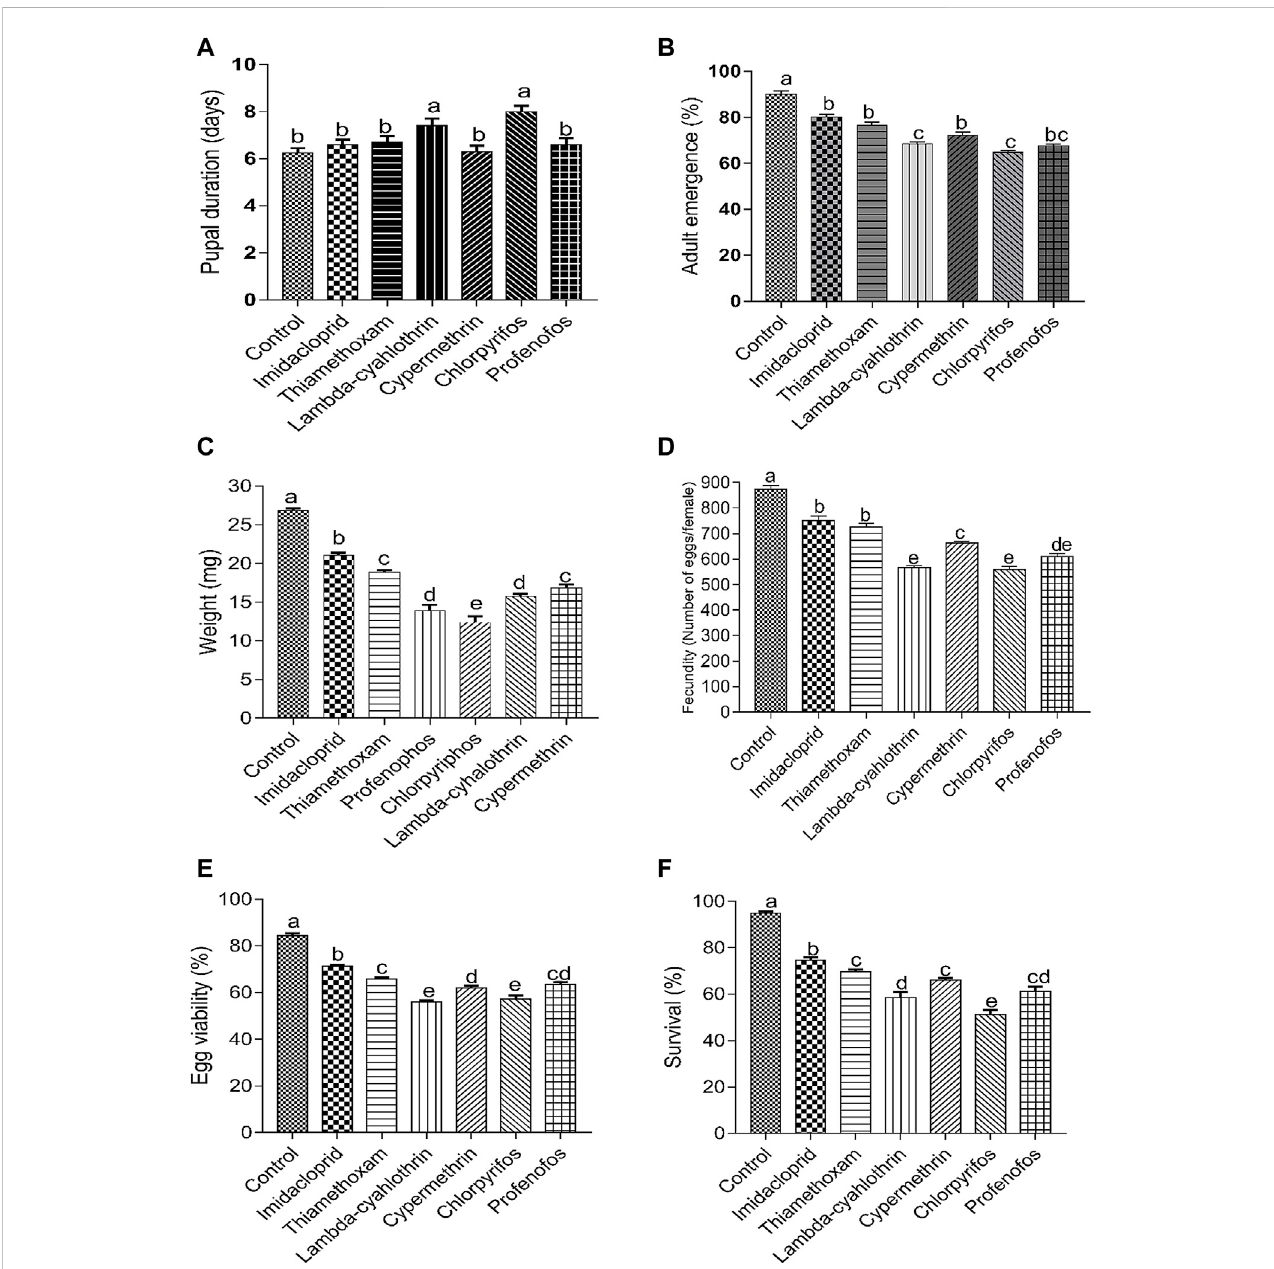
Effect of sublethal concentrations (LC 30 ) of synthetic insecticides on the pupal duration (A) , adult emergence (B) , weight of newly-emerged adults (C) , fecundity (eggs/female) (D) egg viability (E) and adult survival (F) of the F 0 generation of Coccinella septempunctata . Larvae of Coccinella septempunctata wereexposedtosublethalconcentrationsofimidacloprid,thiamethoxam,profenofos,chlorpyrifos,lambda-cyhalothrinandcypermethrin.Treatmentmeans were compared by Tukey ’ s Honest Signi fi cant Difference (HSD) post hoc test. Means with the same letters are not signi fi cantly different at p ≤